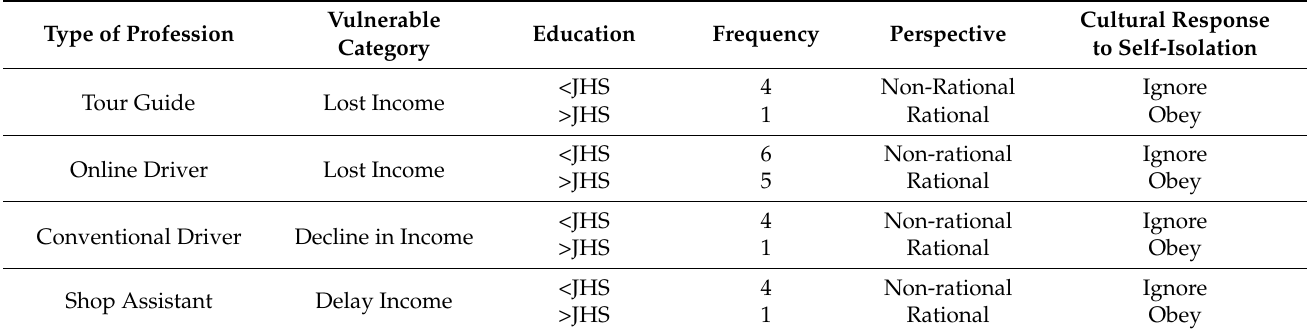
Table 3. The cultural responses of informal workers to the self-isolation